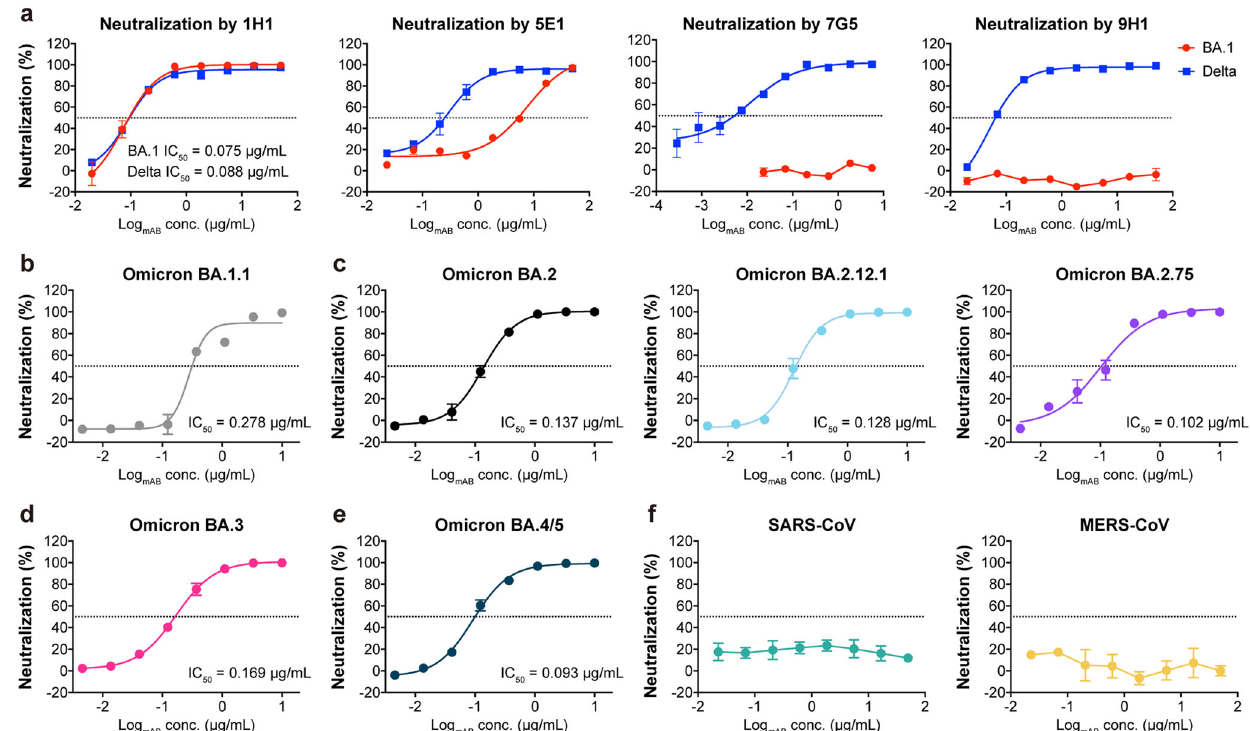
Fig. 1 1H1 neutralizes SARS-CoV-2 sublineages. a neutralizing potency evaluation of 1H1, 5E1, 7G5 and 9H1 against pseudoviruses of Delta and Omicron BA.1. b – g neutralization of pseudotyped Omicron sublineages BA.1.1 ( b ), BA.2, BA.2.12.1 and BA.2.75 ( c ), BA.3 ( d ) and BA.4/5 ( e ) by 1H1. f neutralization of pseudotyped SARS-CoV (left) and MERS-CoV (right) by 1H1. Dashed line indicates a 50% reduction in viral neutralization. Data are shown as the mean of independent triplicates. Error bars indicate standard deviation (SD) of at least three biological